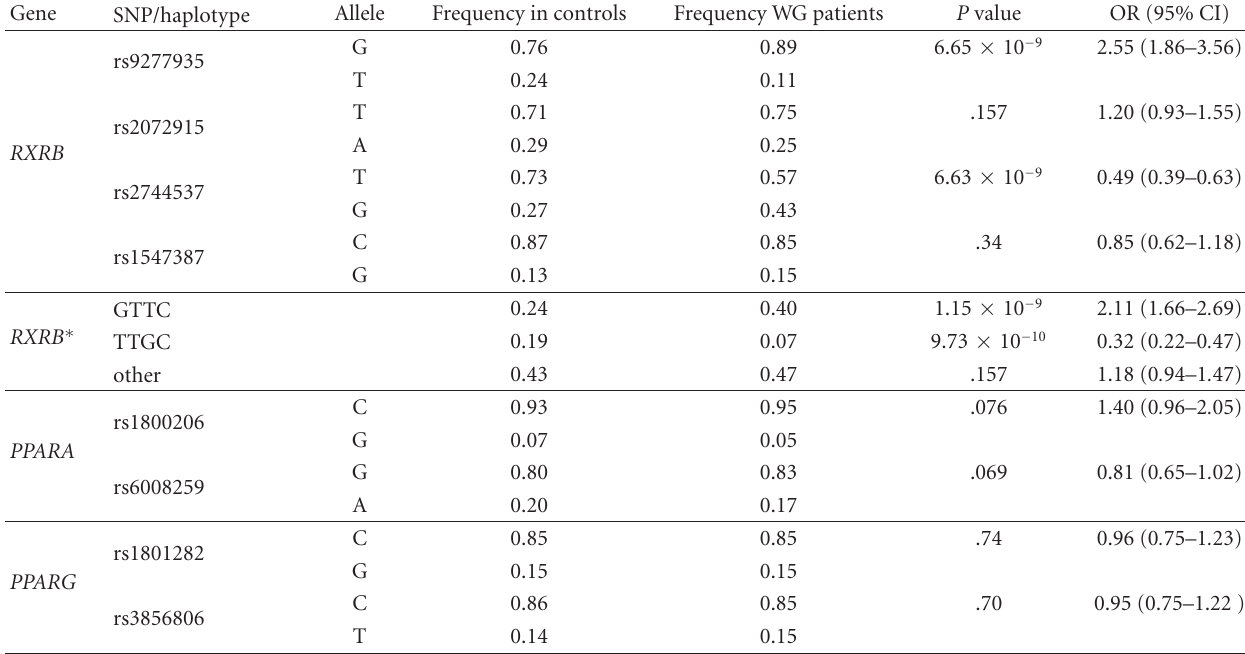
Table 2: Allele and haplotype frequencies.